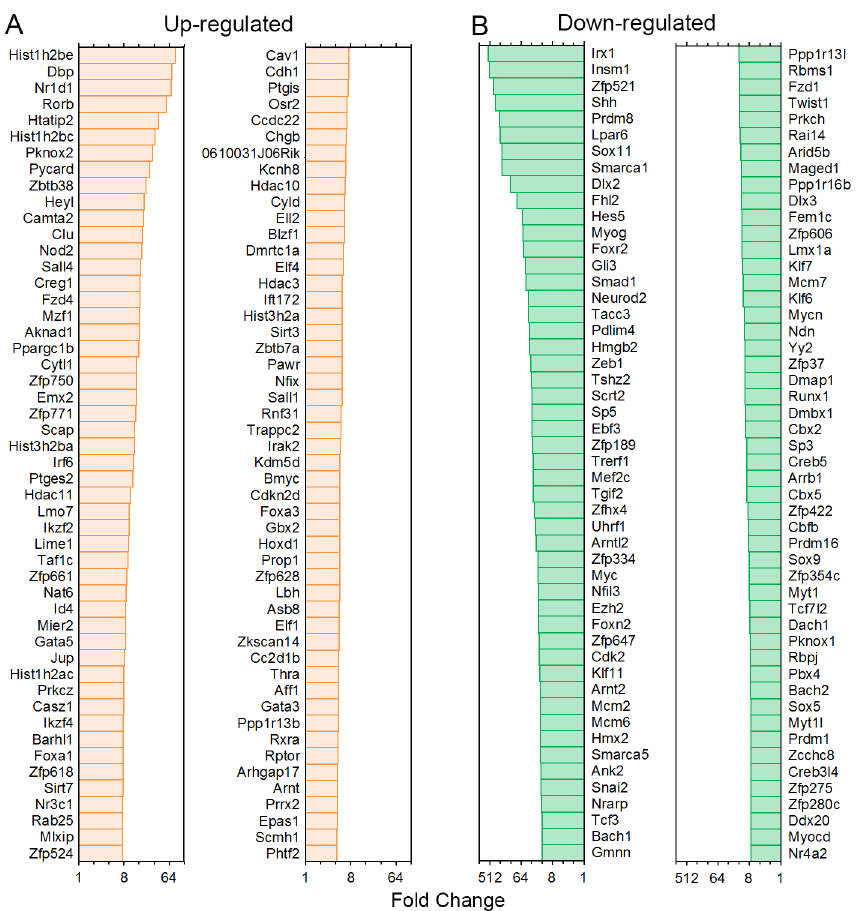
Fig 5. The top 100 TF genes that are up- and down-regulated the expression levels between E16 and P7 were compared with P7 as